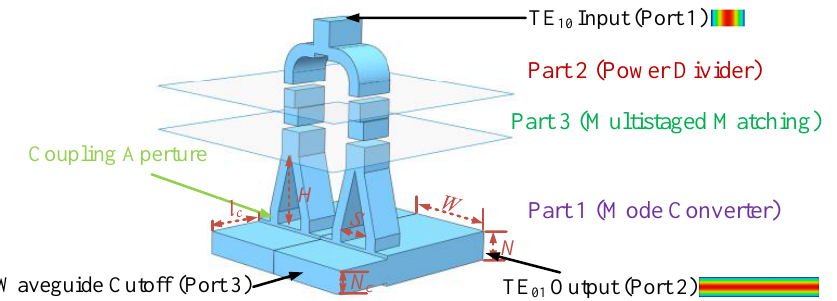
Figure 3. Schematic of a TE 01 mode converter for rectangular gyro-TWT.